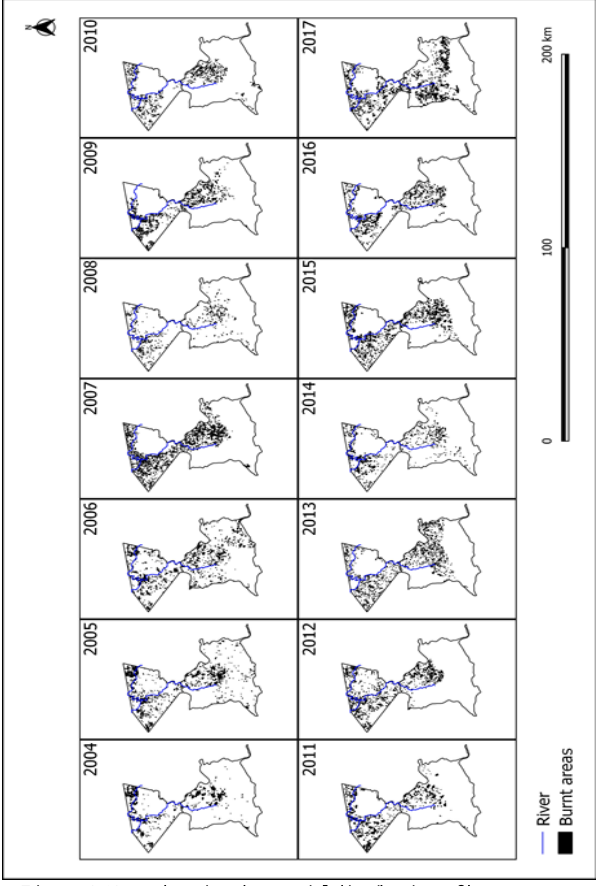
Figure 3. Classes delineated for classification Figure 4. Map showing the spatial distribution of burnt areas each year 2004-2017 The percent of the total cultivated area under varying fallow cycles is observed in figure 4. The results of the classification were simplified and grouped into five principal groups, areas that were identified as single period cultivation, and areas with fallow years of 1-3 years, 4-6 years, 7-9 years and ≥ 10 years.